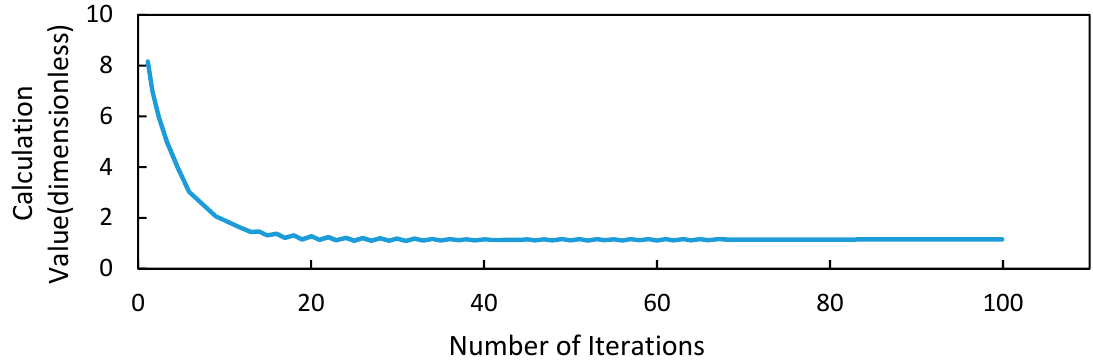
Figure 21. The variation trend of vertical force under particle swarm optimization method.